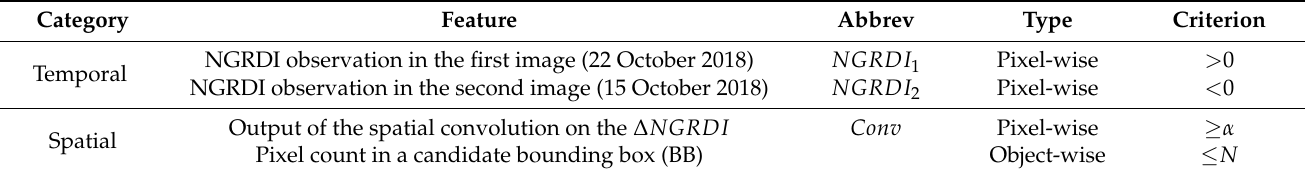
Table 2. The criteria for the spatiotemporal features extracted from image pair to distinguish the pine wilted trees.